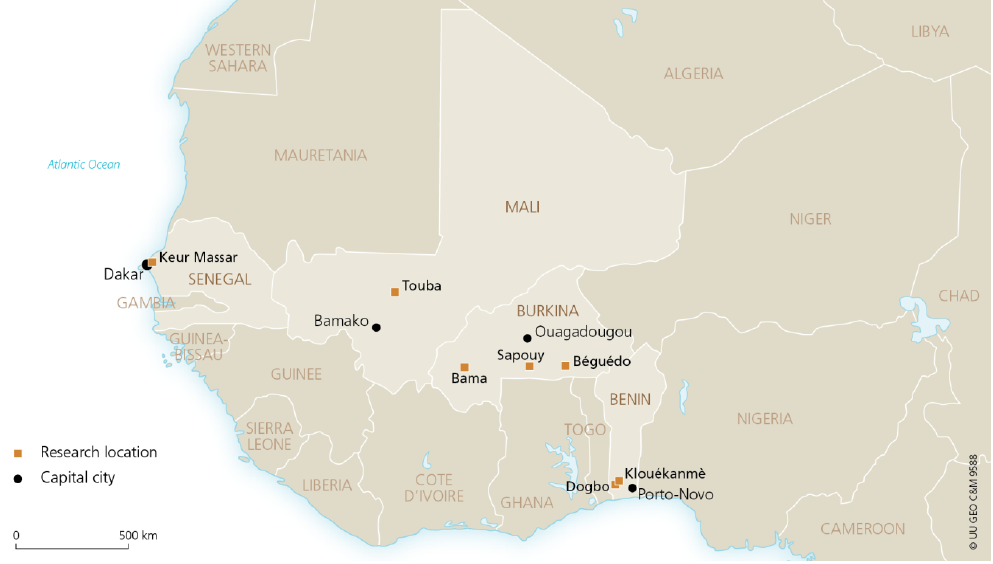
Figure 1. Overview of research locations .